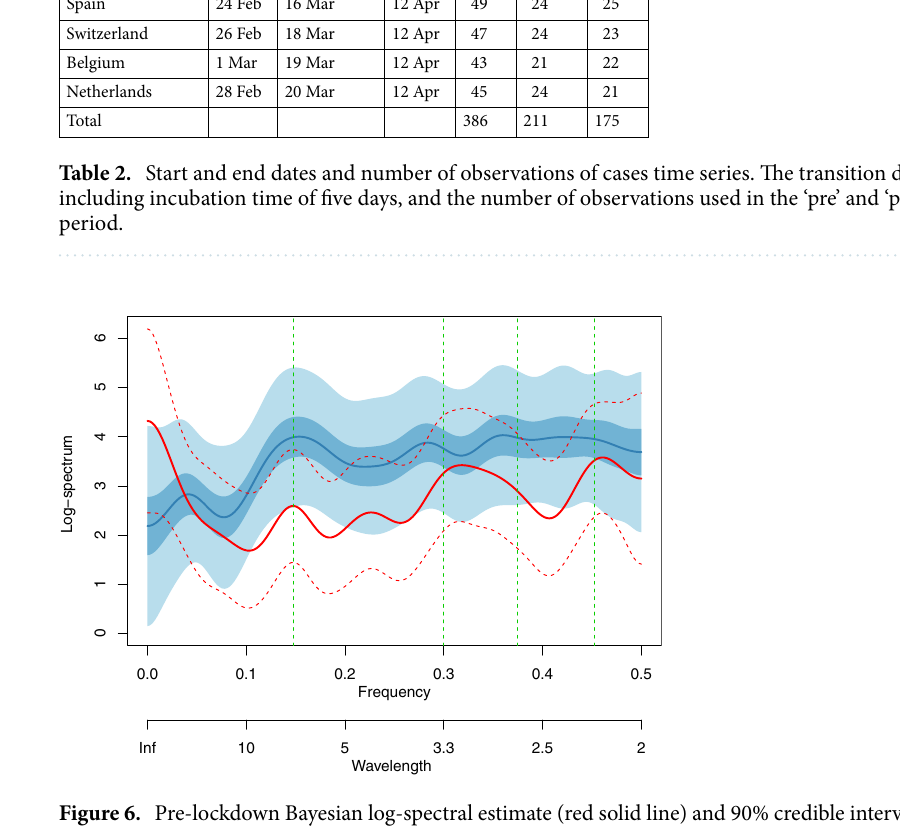
Figure 6. Pre-lockdown Bayesian log-spectral estimate (red solid line) and 90% credible interval (red dashed lines). Post-lockdown log-spectral estimate (blue solid line) and 50% and 90% credible intervals. Green vertical dashed lines from left to right indicate wavelengths of 6.74 (weekly), 4.42, 3.14, and 2.17